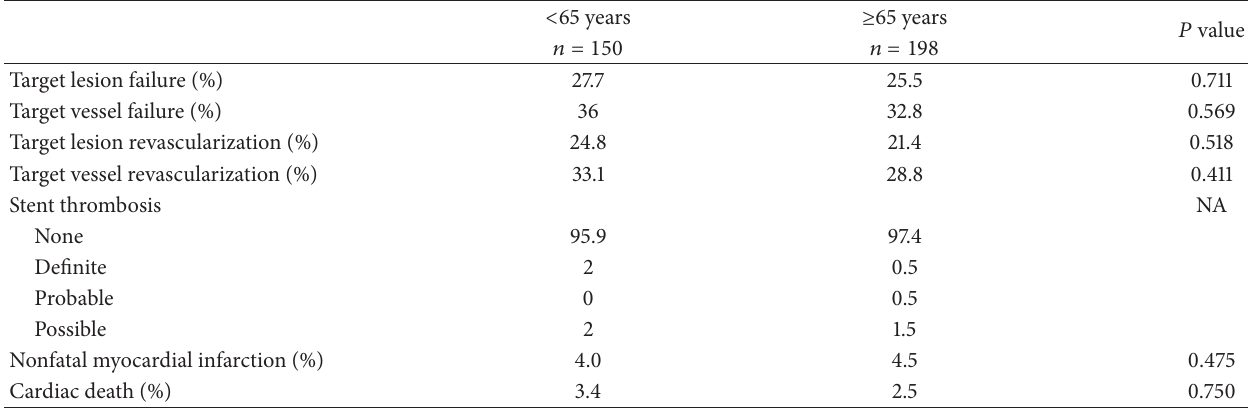
Table 4: Two-year primary and secondary